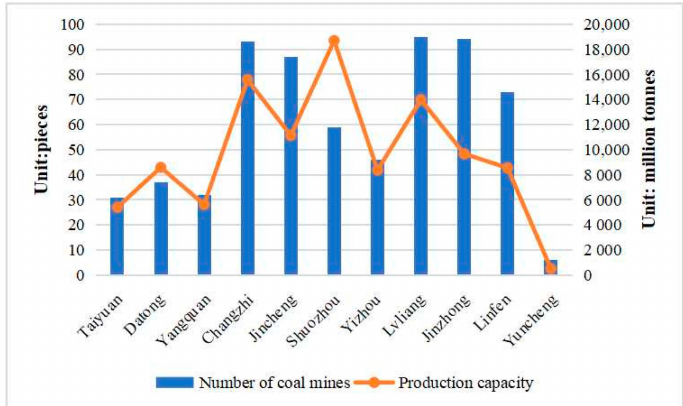
Figure 4. Number and capacity of producing coal mines in Shanxi Province.